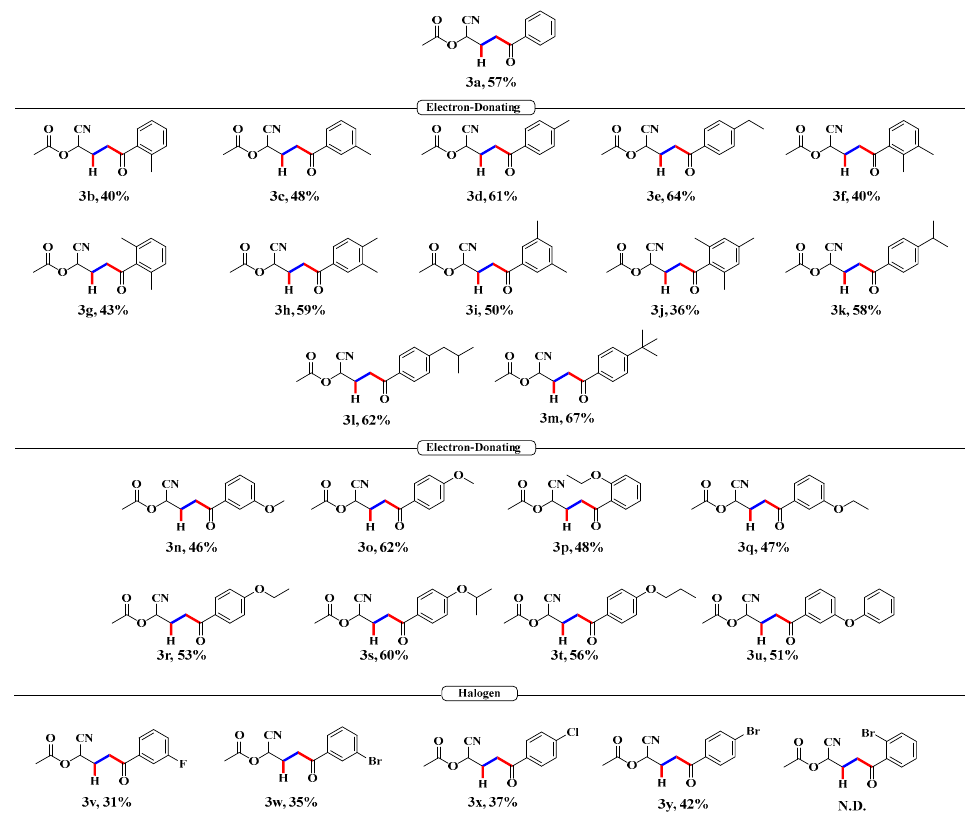
Figure 1. The substrate scope of benzaldehyde.